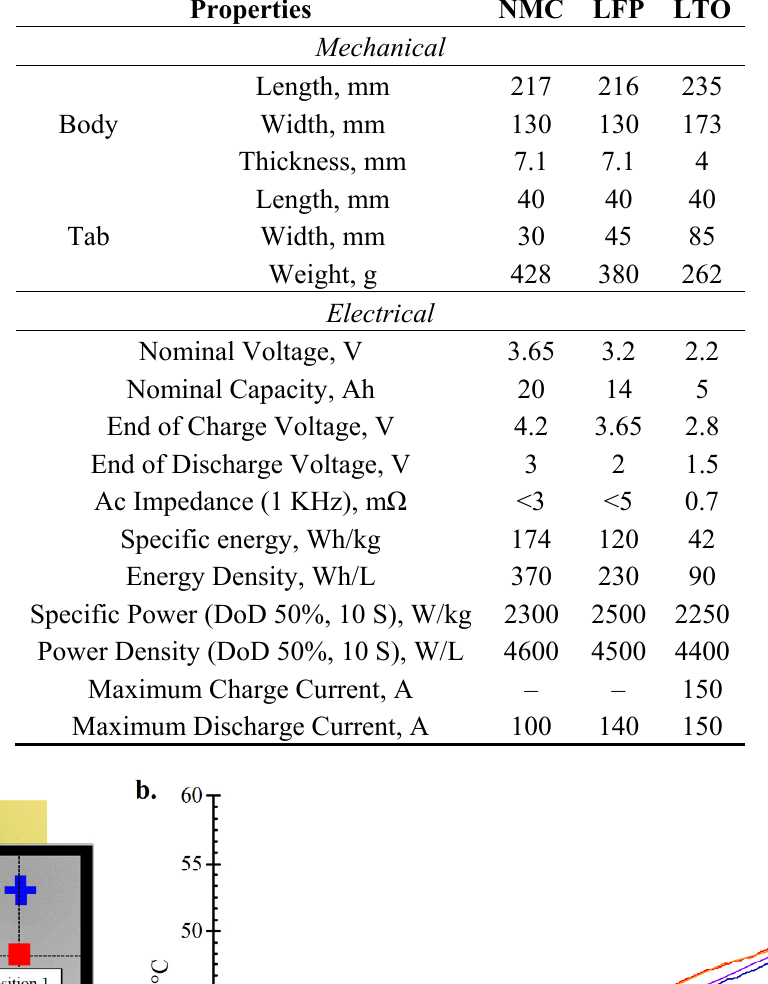
Table 1. Mechanical and electrical properties of the NMC, LFP and LTO Cells.